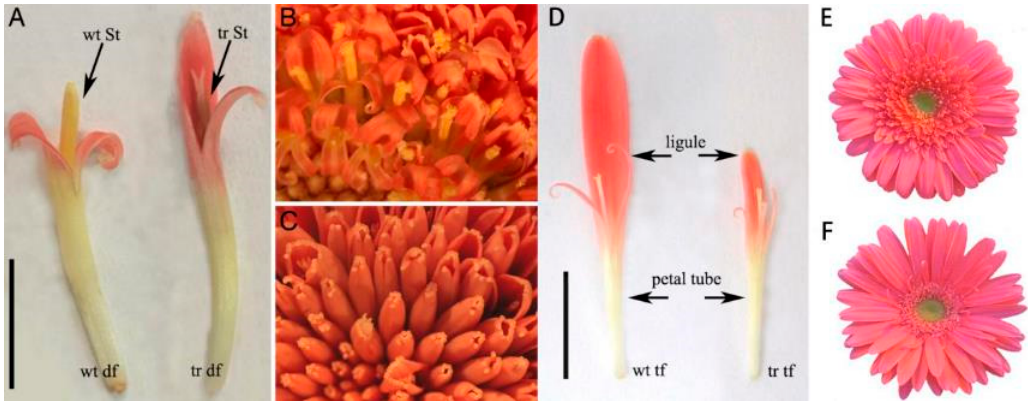
Figure 4. G. hybrida with GhCYC2a overexpression ( A – C ) and inhibition ( D – F ) [71]. ( A ) Disc florets (df) of wild-type (wt) Gerbera hybrida and transgenic (tr) G. hybrida with obvious phenotypic differ- ences. St, stamen. ( B ) Pollen presentation on the style of the disc florets of wild-type G. hybrida . ( C ) Disc florets of transgenic G. hybrida lacking functional stamens. ( D ) Transitional floret (tf) of wild- type and transgenic G. hybrida . ( E ) Capitulum of wild-type G. hybrida . ( F ) Capitulum of genetically modified G. hybrida . Reprinted with permission from Ref. [71]. Copyright © 2023 by The National Academy of Sciences of the USA.